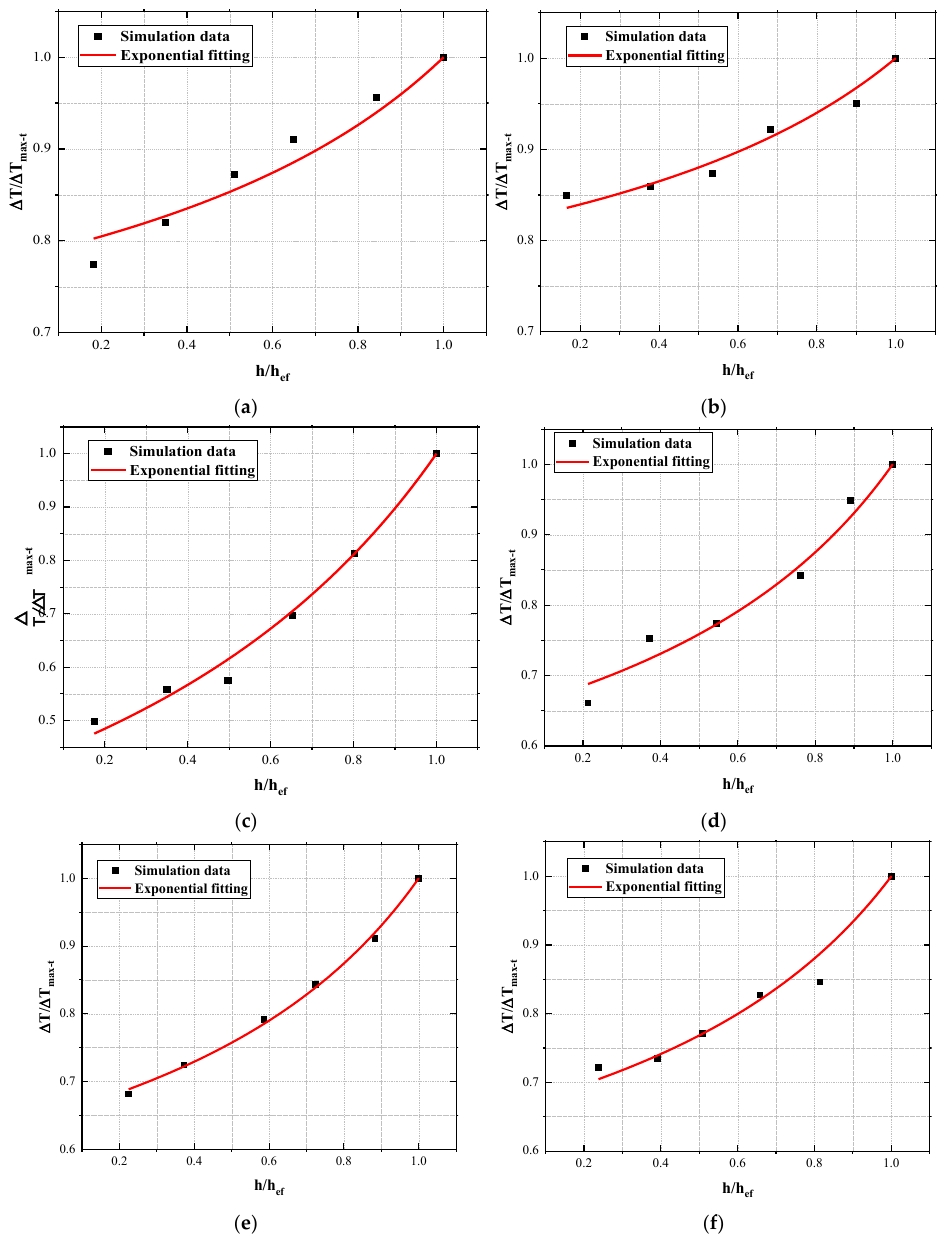
Figure 8. Excess temperature along the truss versus normalized effective height: ( a ) H = 9.8; ( b ) H = 10.6; ( c ) H = 11.4; ( d ) H = 12.2; ( e ) H = 13.0; ( f ) H =